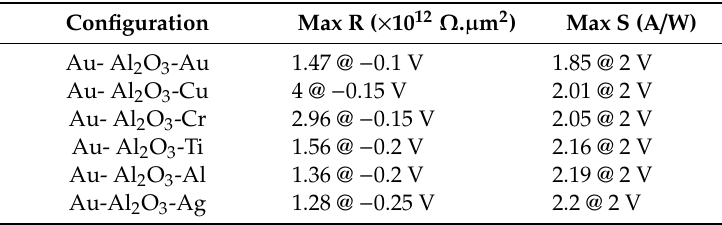
Table 4. Maximum resistance (R) and responsivity (S) for the di ff erent metals of the MIM-diode at 28.3